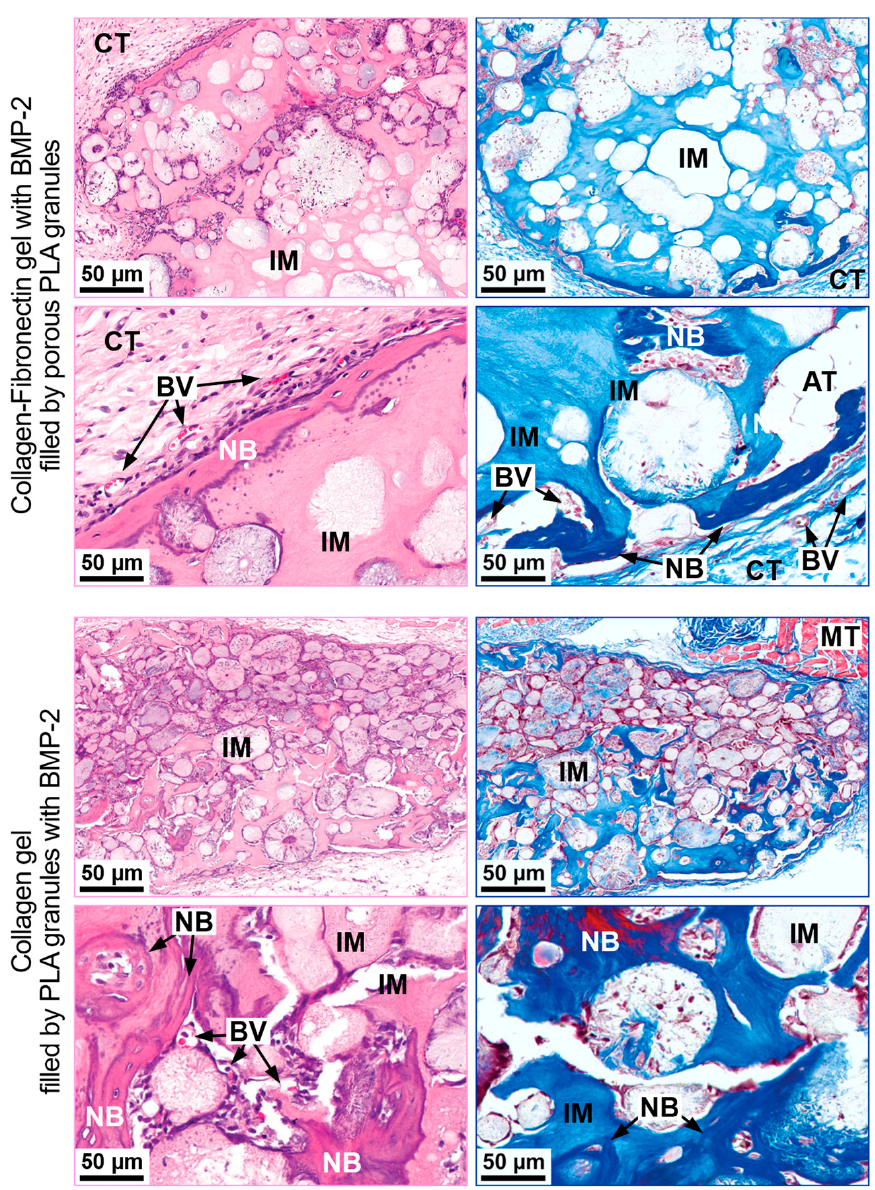
Figure 6. Subcutaneous implantation of the materials. H&E ( left column) and Masson staining ( right column). IM—implanted material, CT—connective tissue, BV—blood vessel NB—newly formed bone, GC—giant cells, AT—adipose tissue, MT—muscle tissue.